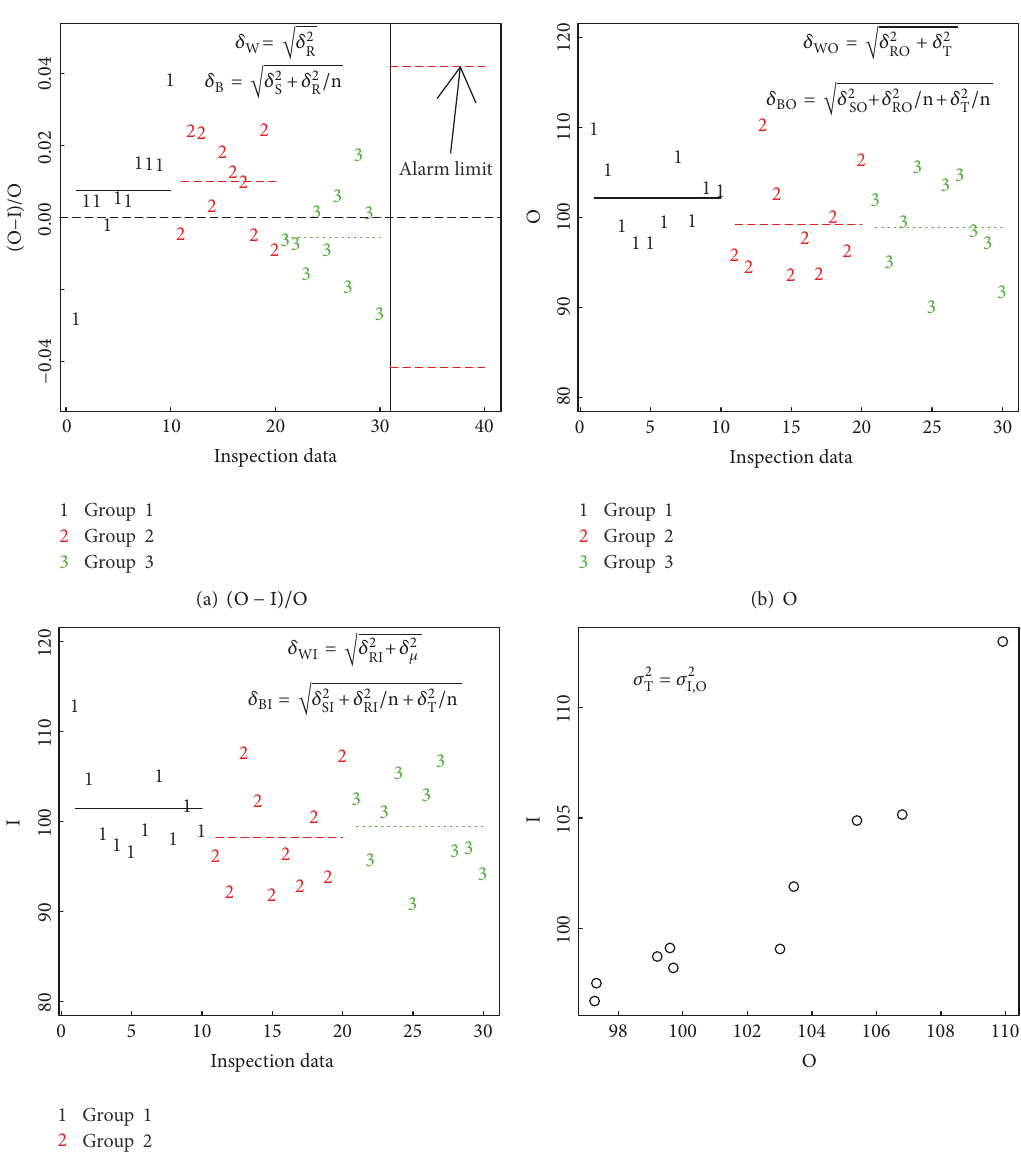
(d) Inspector versus operator data in group 1